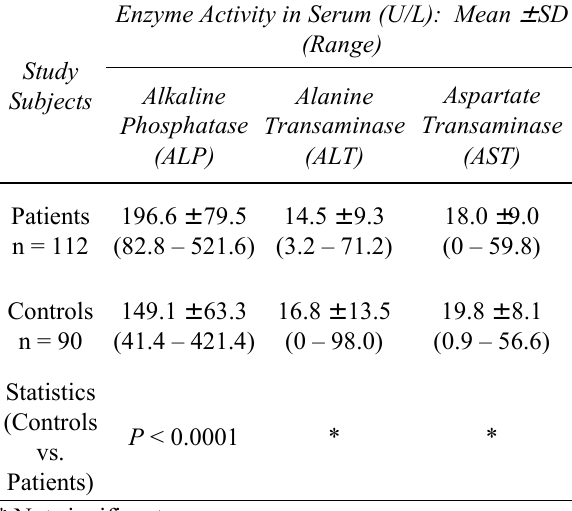
Table 1: Activities of ALP, ALT and AST in